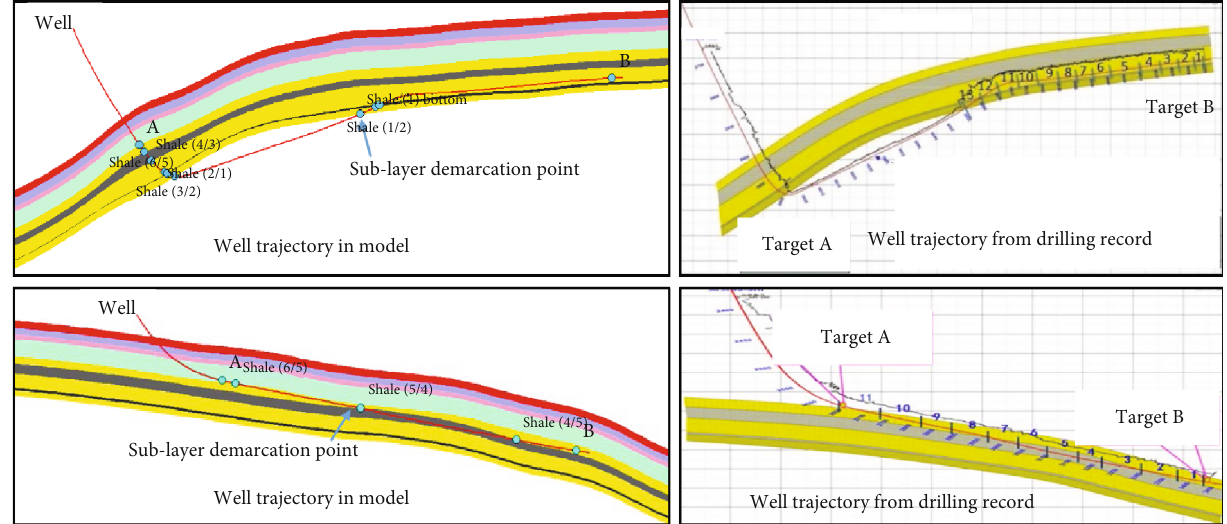
Figure 7: Comparison between the results of the shale stratigraphic framework model and the actual drilling trajectory